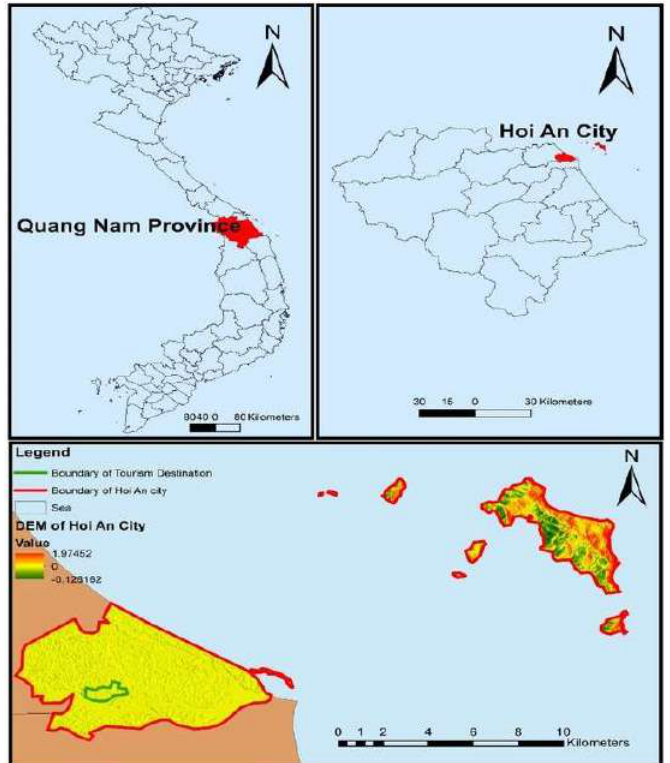
Fig. 1: Geographic location of the study area and topographic conditions of Hoi An city in Vietnam